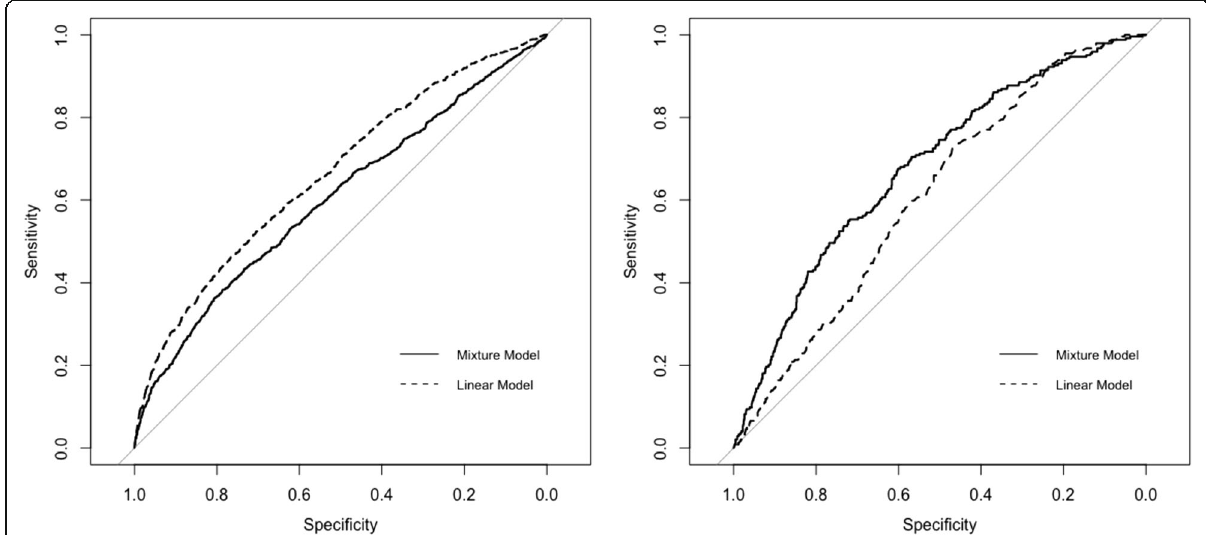
Fig. 2 Receiver operating characteristic curves for the linear (dashed) and mixture (solid) models predicting maximum 2-day creatinine change (left) vs. eGFR90